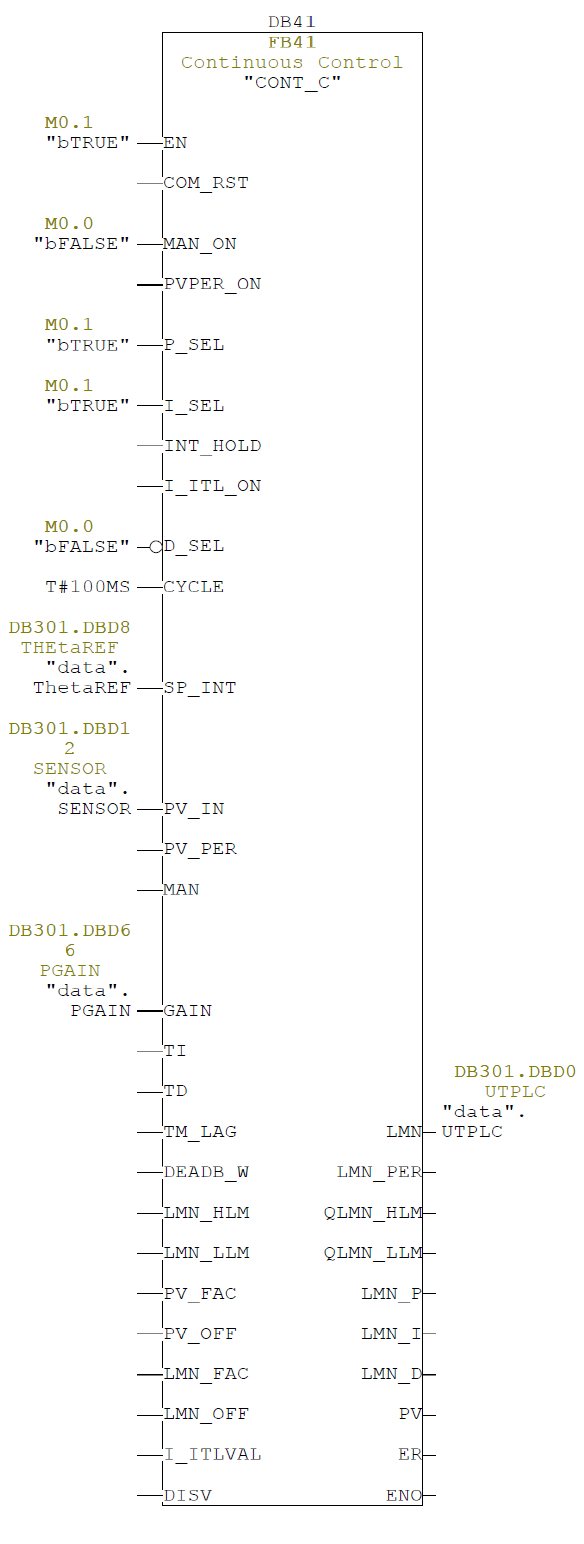
Fig. 10 The OB35 continuous block as used in STEP7. Figure 10. The OB35 continuous block as used in STEP7